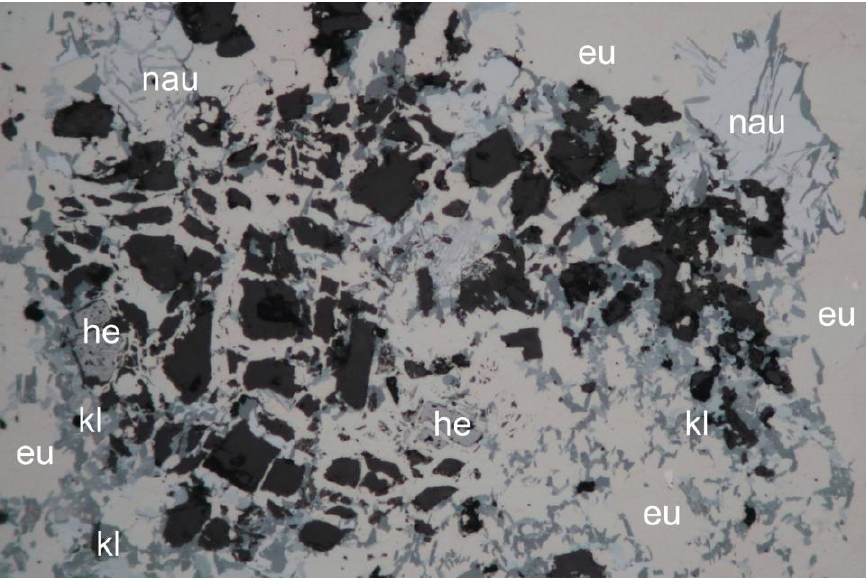
Figure 7. Detail from Se vein Type 1: A granular aggregate of eucairite (eu), klockmannite (kl), and naumannite (nau) is partially replacing a host rock fragment along the grain boundaries of K-feldspar (black) and hematite (he, grey). Reflected light image, 500-μm-wide, plane polarized light.